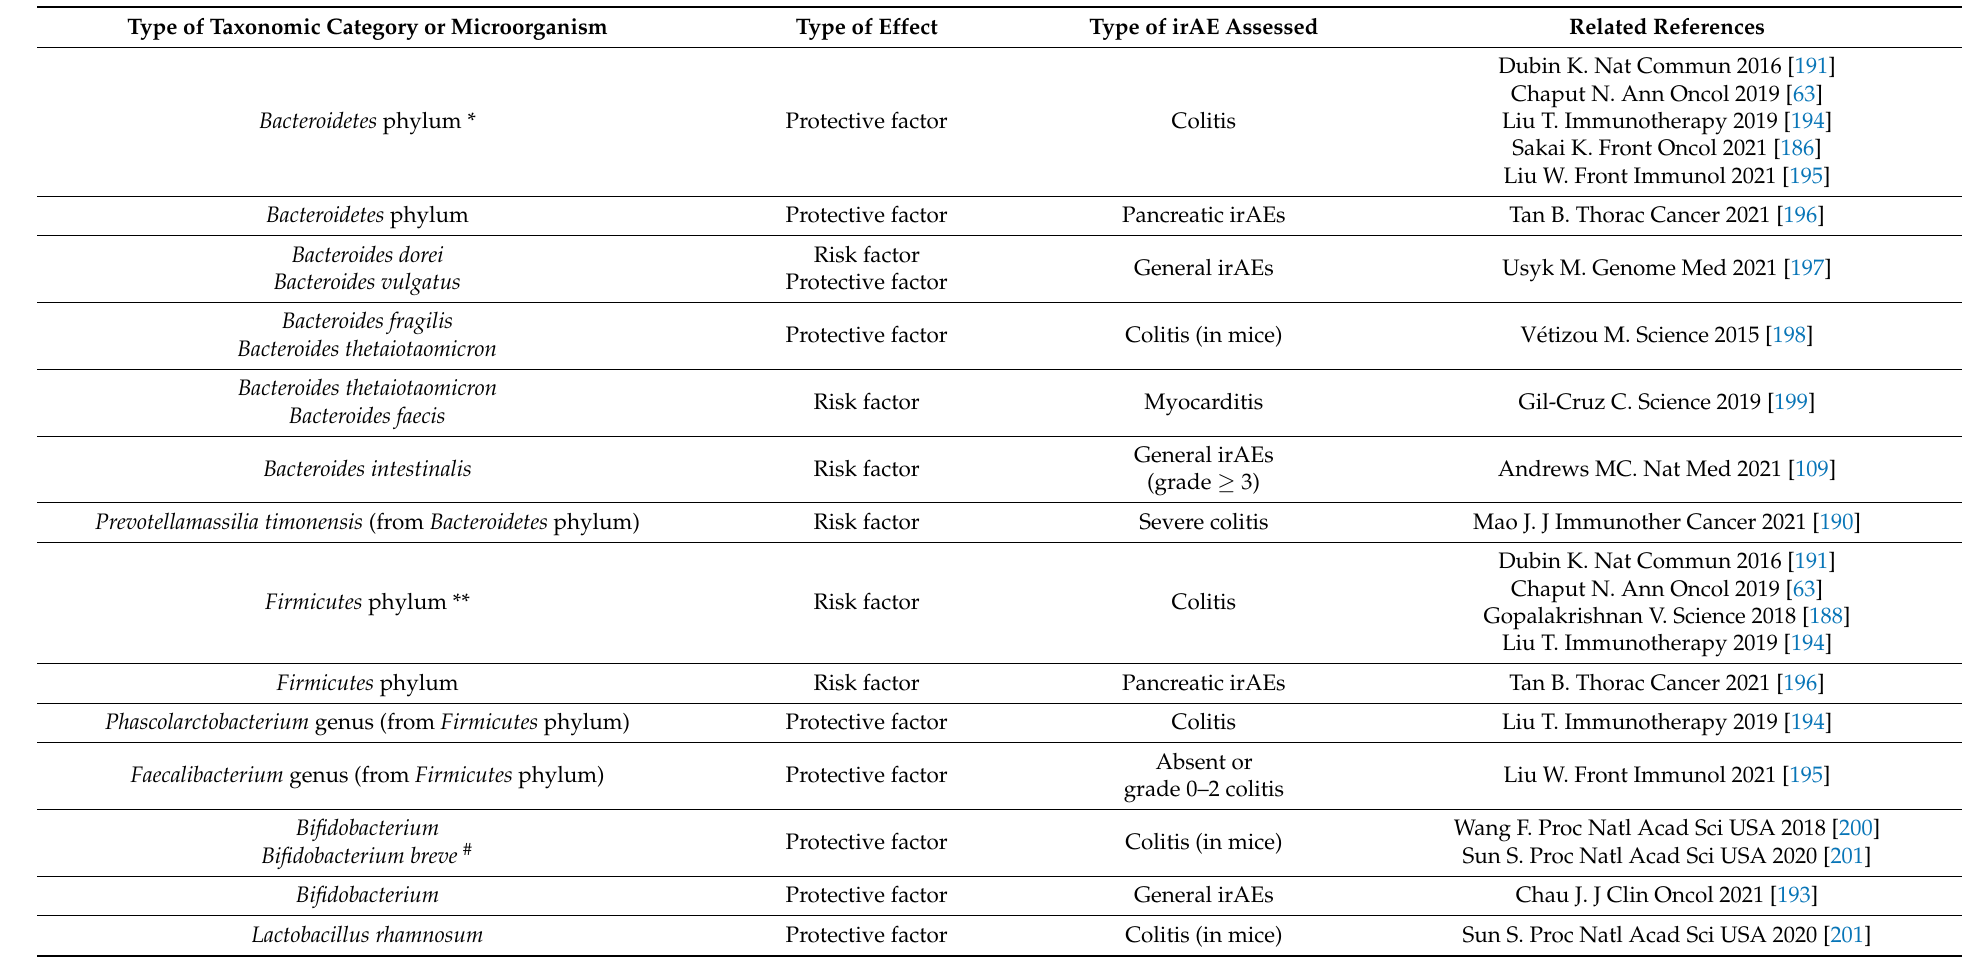
Table 4. Summary of gut microbiome members related to the risk of developing immune-related adverse